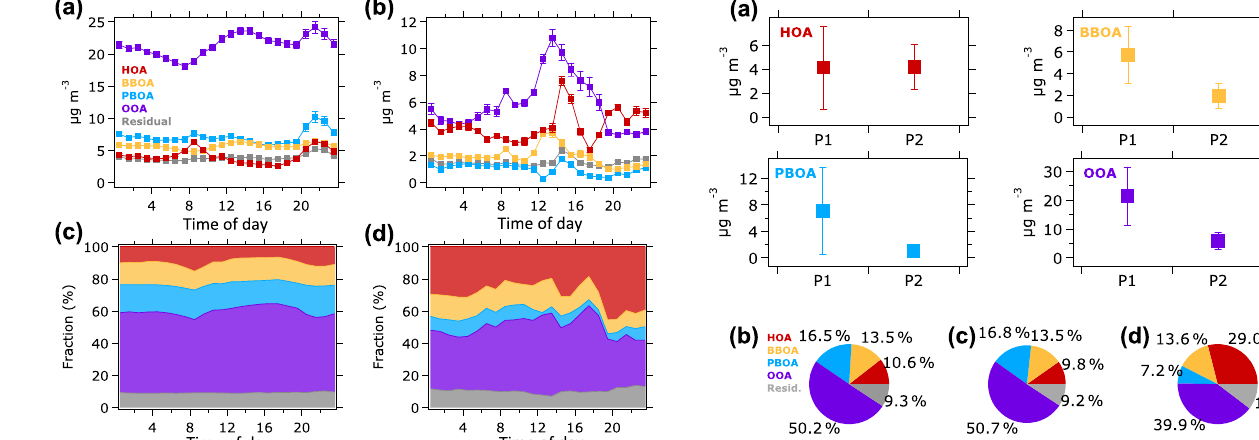
Figure 5. Average diurnal profiles of OA sources in units of µgm − 3 (top panels) for (a) the P1 and (b) P2 periods. Bottom panels show similar diurnal profile but in fraction contribution to the total OA mass for (c) the P1 and (d) P2 periods.